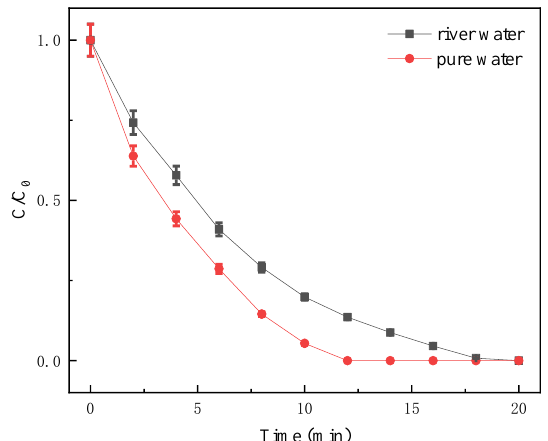
Figure 11. Degradation effect of O 3 /PMS on SDZ in different water samples (reaction conditions: pH = 6.8 ± 0.1, SDZ = 10 mg/L, O 3 = 3 mg/L, T = 25 ± 0.5 °C, O 3 = 3 mg/L, PMS = 22.8 mg/L).